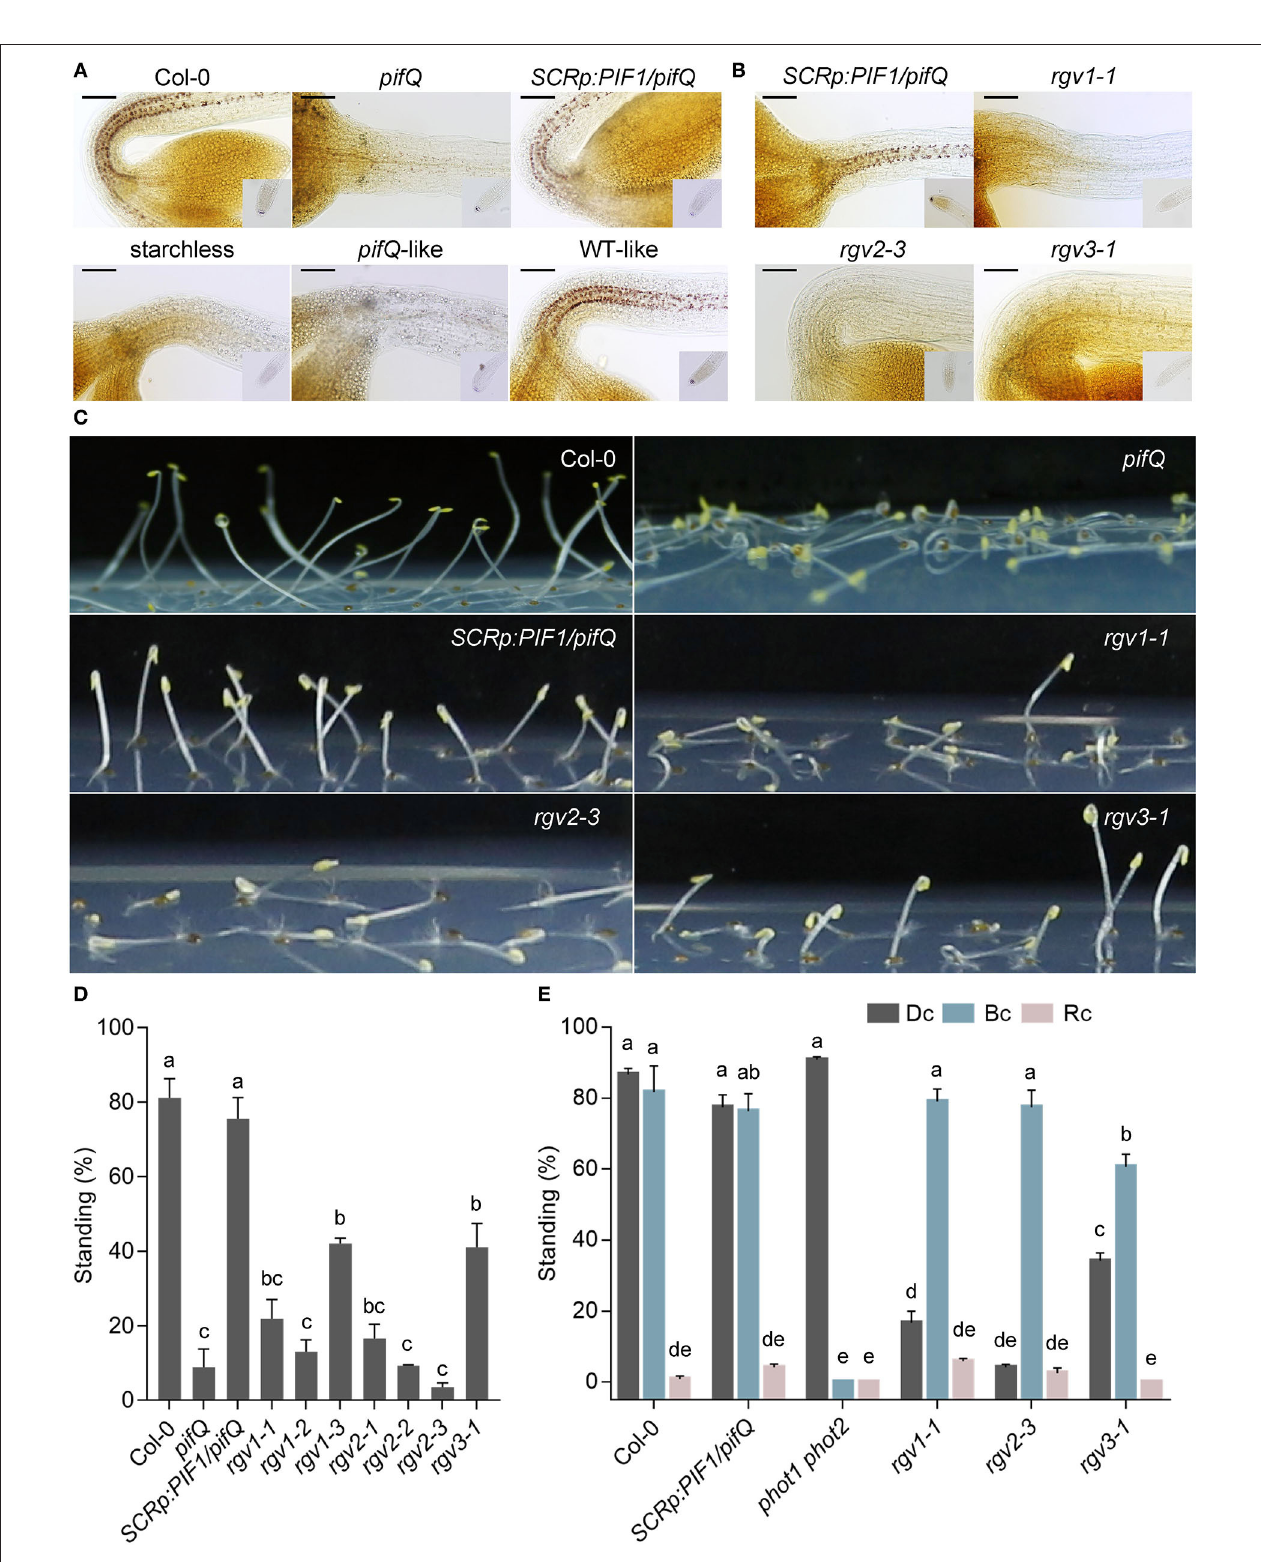
FIGURE 1 | Three reduced gravitropic ( rgv ) mutants lack endodermal starch granules and show reduced hypocotyl negative gravitropism. (A) Classification of rgv mutants into three groups based on the presence of endodermal starch granules. Endodermal starch granules were visualized by staining 3-day-old